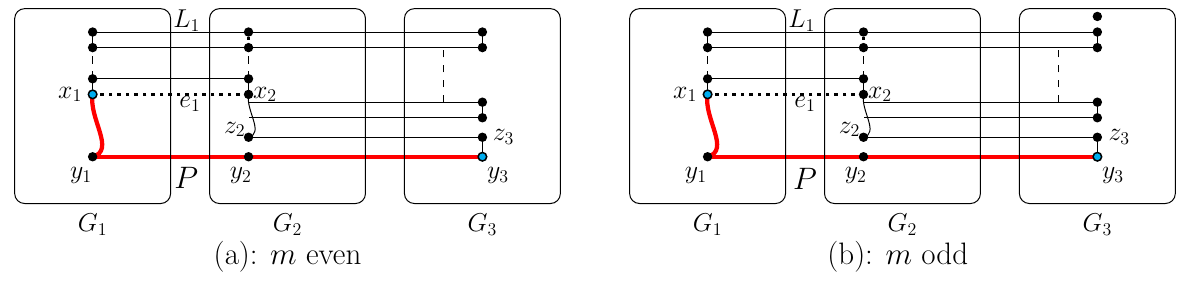
Figure 5: Cycles containing P when n =